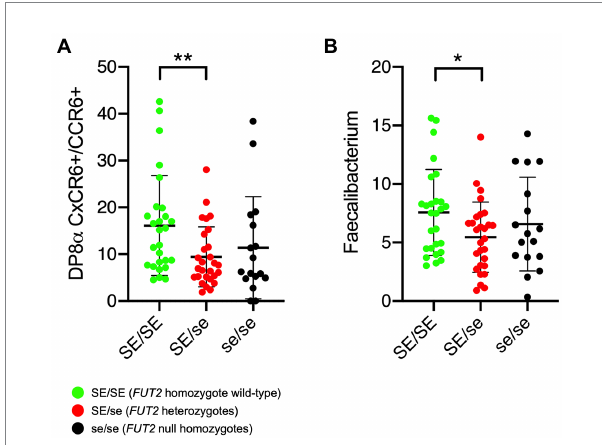
FIGURE 2 Relationship between the FUT2 status and either DP8 α Treg cells or the Faecalibacterium prausnitzii proportions. (A) Frequencies of circulating DP8 α Treg cells quantified as described in the methods section (per 10.000 total CD3 + cells). (B) Relative abundance of the bacterium are given as percentage of the whole microbiota based on 16S metabarcoding. Comparisons were performed by two-sided Mann–Whitney test: * p < 0.05; ** p < 0.01. SE/SE = FUT2 homozygote wild-type (green symbols); SE/se = FUT2 heterozygotes (red symbols); se/se = FUT2 null homozygotes (black symbols).